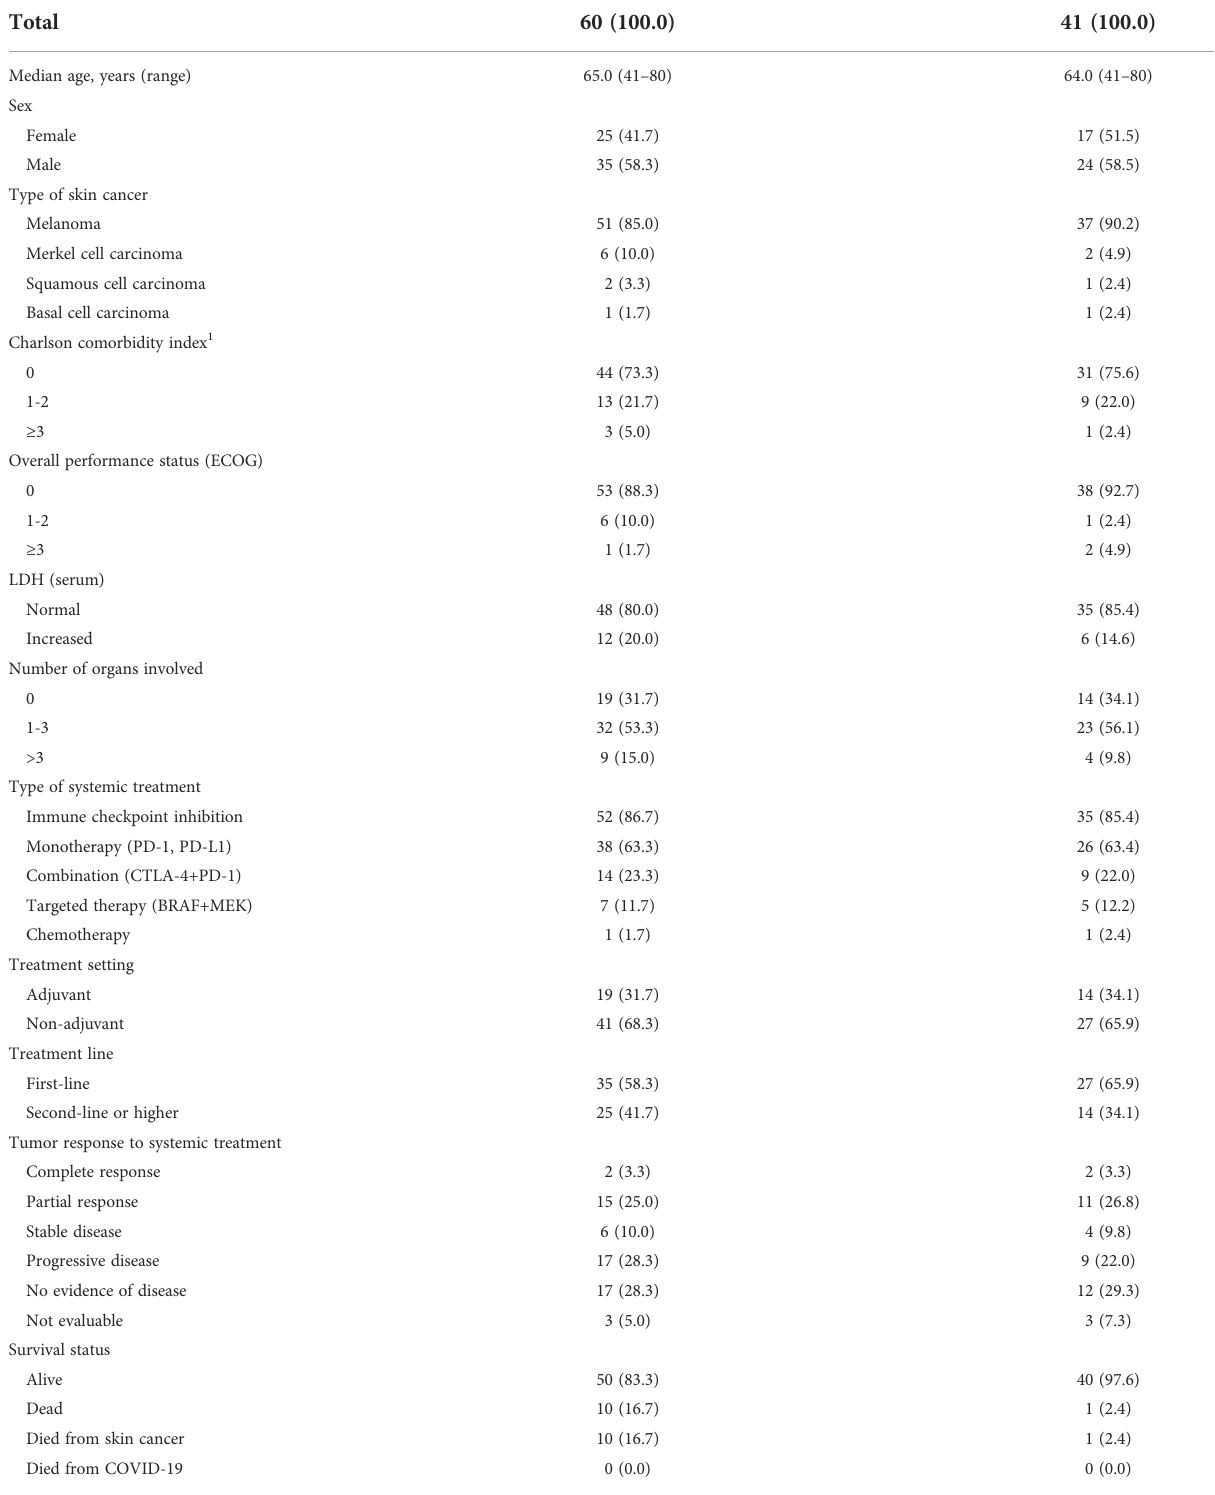
TABLE 1 Patient